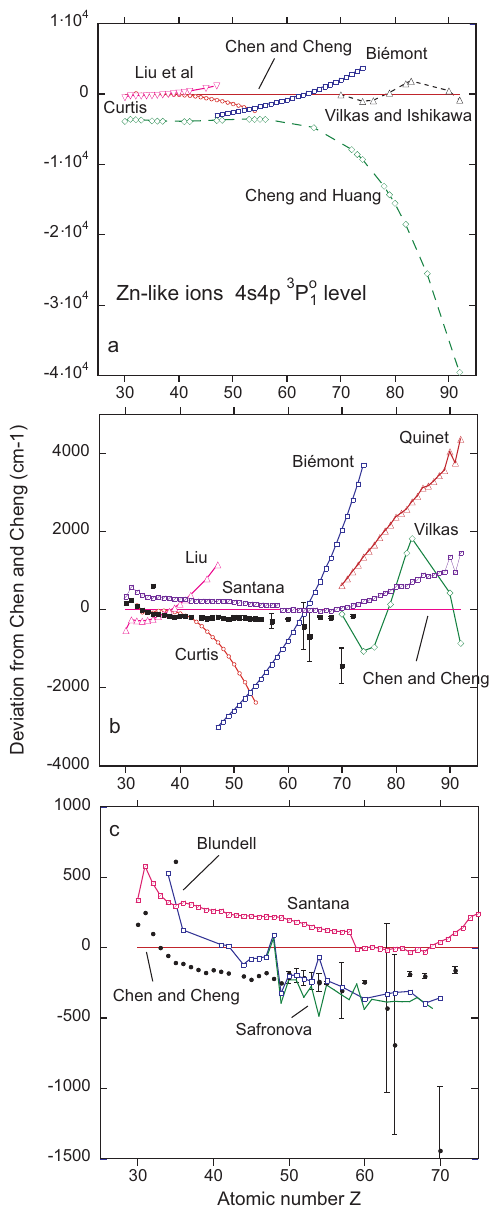
Figure 5. Deviations among calculations and measurement for the 4s4p 1/2 3 P o level in Zn-like ions. 1 All entries are shown relative to the results of the relativistic configuration interaction (RCI) computations by Chen and Cheng [12] (magenta line at zero). The experimental data (full black symbols) have been taken from the compilations by NIST [21], by Churilov et al. [41] (both without error bars) and from the experiment by Brown et al. [44] (with error bars). Note that for Z = 35, the NIST online database has an entry that is clearly off the trend of all other experiments. ( a ) (Top panel) The emphasis is on the oldest of the computations. There are large deviations especially at high Z . ( b ) (Middle panel) The poorest computations of ( a ) have been replaced with some newer ones and the vertical scale expanded. Note how the isoelectronic trends of some computations deviate from the experimental data. ( c ) (Bottom panel) Only the computations with the smallest deviation from experiment are shown. Key to computations: Curtis [77], Biémont et al. [80,81], Cheng and Huang [89], Vilkas and Ishikawa [84], Liu et al. [83], Quinet et al. [82], Blundell [85], Safronova et al. [87], Santana